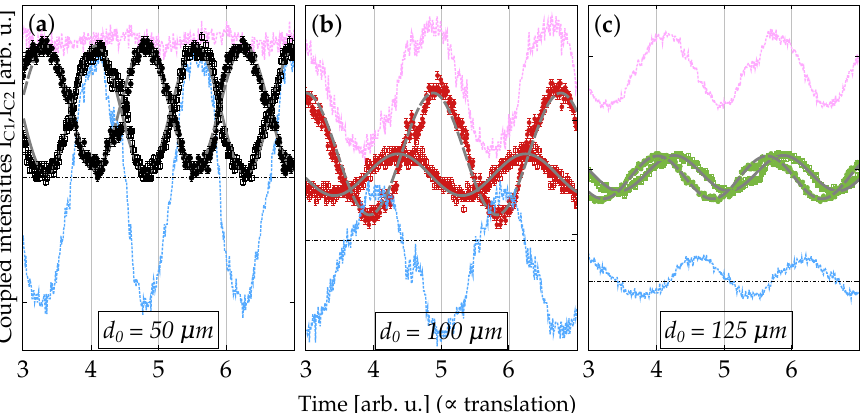
Figure 5. Experimental data for the coupled intensities as a function of time during ramping up the voltage to the piezo-translation stage. Time is directly proportional to the traveled distance along the grating vector. t p = 12 s, λ r = 355 nm and: ( a ) d 0 = 50 µ m (black symbols); ( b ) d 0 = 100 µ m (red symbols); ( c ) 125 µ m (green symbols). Grey dashed lines are fits according to the theory (cf. Section 4.3). The pink and blue lines are the sum ( Σ ) and the difference ( ∆ ) of the coupled intensities, respectively (see the text); dash-dotted horizontal lines denote zero